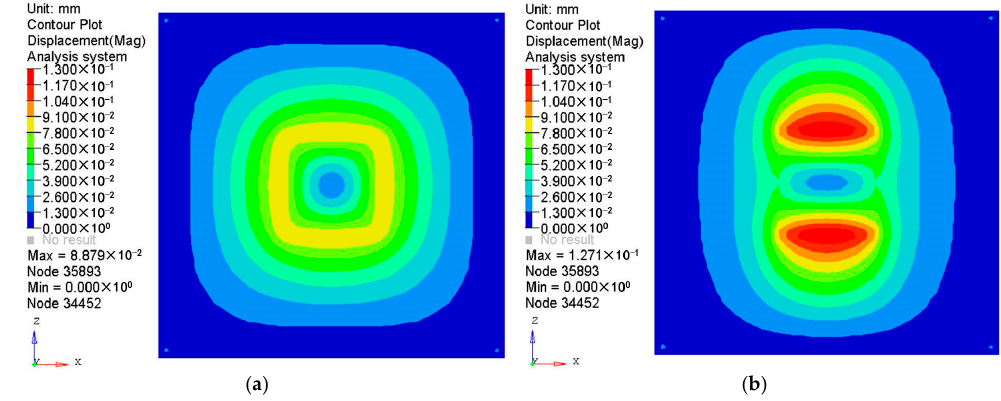
Figure 5. Displacements of ( a ) isotropic and ( b ) orthotropic plates under the temperature difference of 30 K.